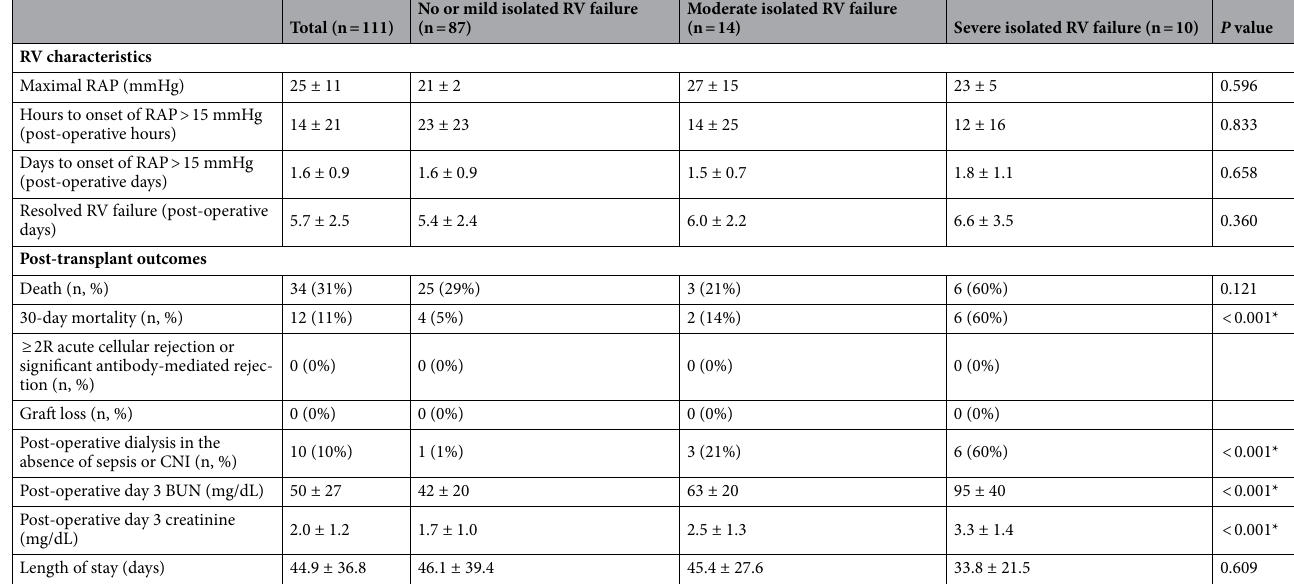
Table 3. RV characteristics and post-transplant clinical outcomes. BUN blood urea nitrogen, CNI calcineurin inhibitor, RAP right atrial pressure, RV right ventricular. *P value < 0.05 is statistical significance.